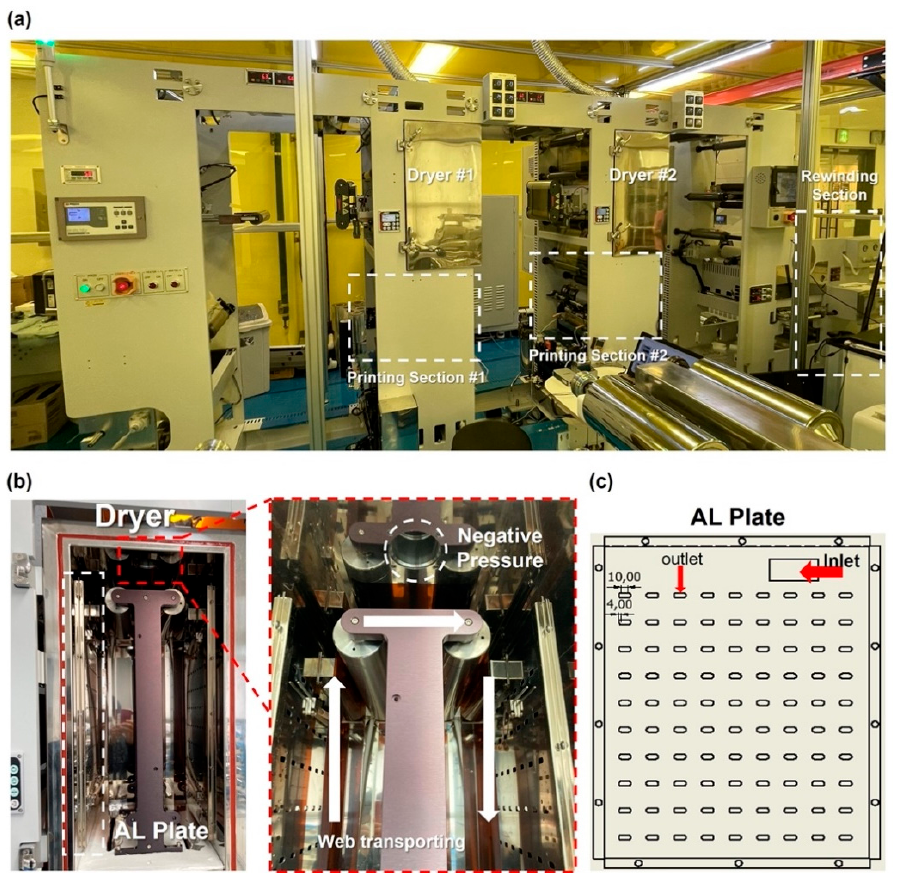
Figure 1. Schematics of the ( a ) R2R continuous system, ( b ) drying chamber, and ( c ) aluminum plate for hot air flow.